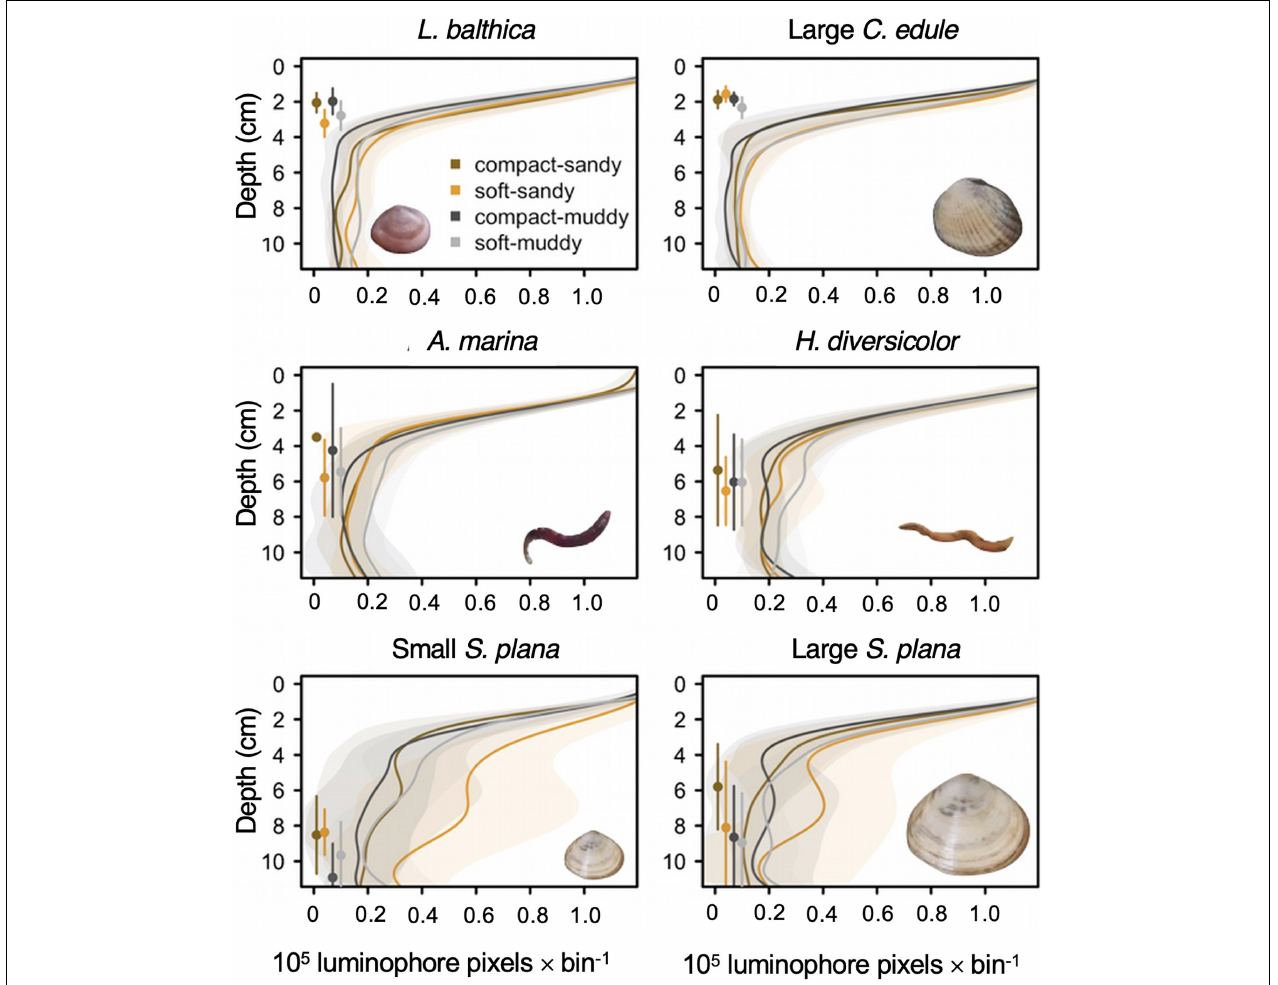
FIGURE 8 | Smoothed average luminophore profiles for L. balthica , C. edule , H. diversicolor , A. marina , and S. plana with standard deviation intervals, showing the incorporation of the luminophores into the sediment. We only show the profiles for the large C. edule because the two size classes produced very similar ones. The luminophores were counted in 0.5 cm bins. Luminophores are added to the sediment surface and permeate through the sediment. Local mixing causes the number of luminophores to decrease exponentially with depth whereas non-local mixing results in an increase of luminophores below the sediment surface. Depths where non-local mixing are dominant typically become visible as (small) bumps in the curve where the luminophore value reaches a local maximum. For example, the S. plana displays non-local mixing at 6–8 cm depth in the soft-sandy sediment. The points to the left of the profiles represent average depth for the species by sediment treatment (as in Figure 6 ), with standard deviations (vertical